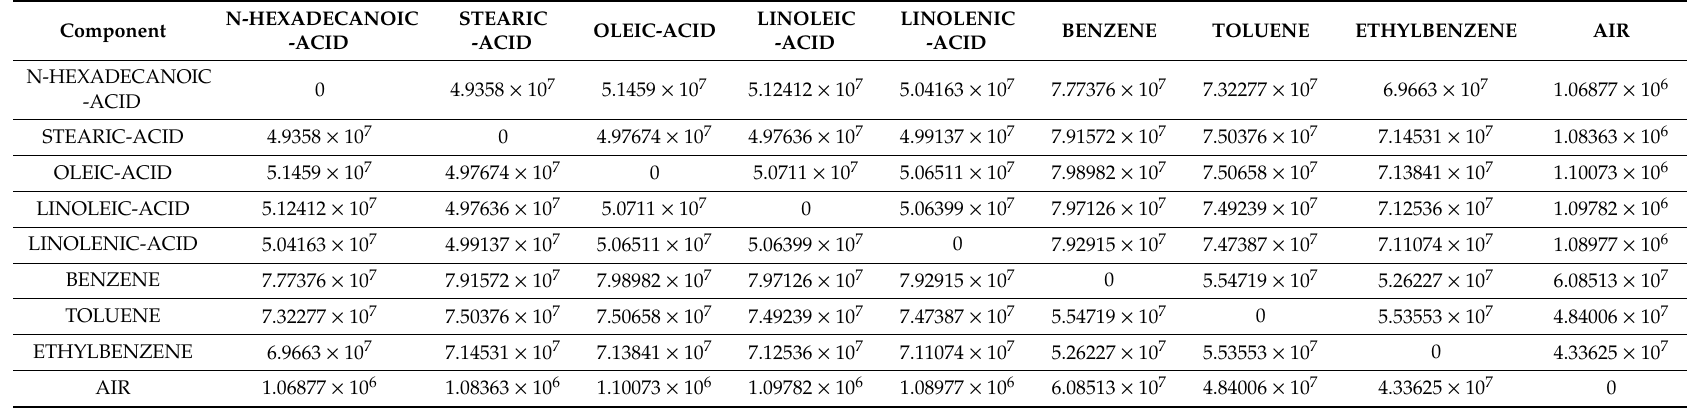
Table 3. Overall binary mass transfer coe ffi cients (kmol / s) used in Aspen PLUS at conditions of an experiment of 30 ◦ C, flow rates 53 mL / min, and at a bed height of 0.5